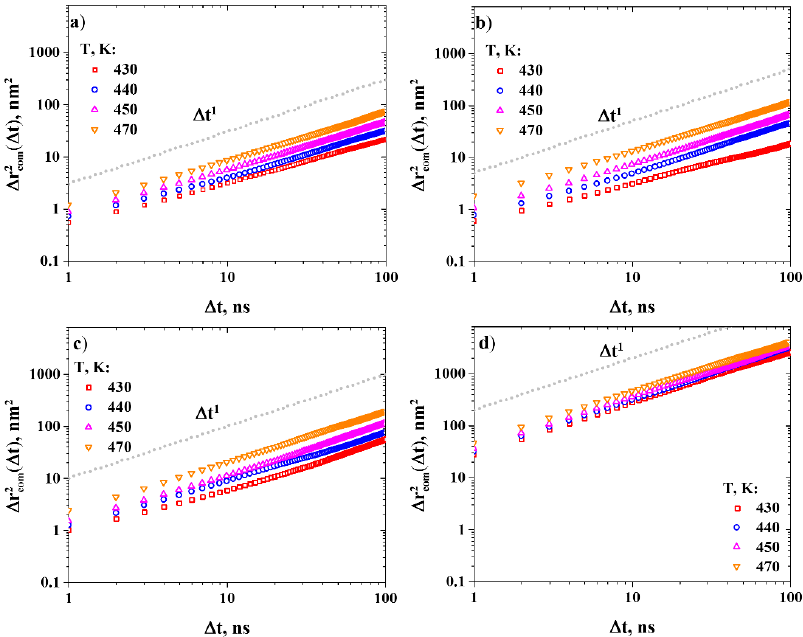
Figure 5. Time dependence of the mean squared displacement (MSD) of ( a ) CH 4 , ( b ) N 2 , ( c ) O 2 , and ( d ) He in R-BAPB, at various temperatures. Double-logarithmic axes. The diffusion coefficients of the gases were calculated from the MSD curves (Figure 6) corresponding to the timescales of the normal diffusion regime (the values of MSD slopes are presented in Supporting Information, Figure S4).